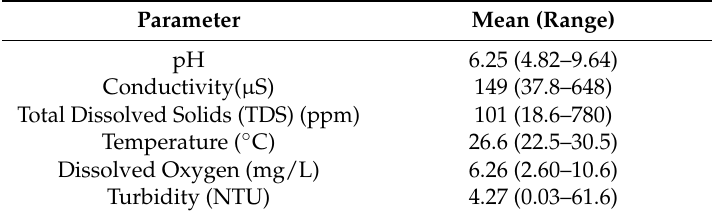
Table 1. Physico-chemical water quality parameters for 2016 rainwater